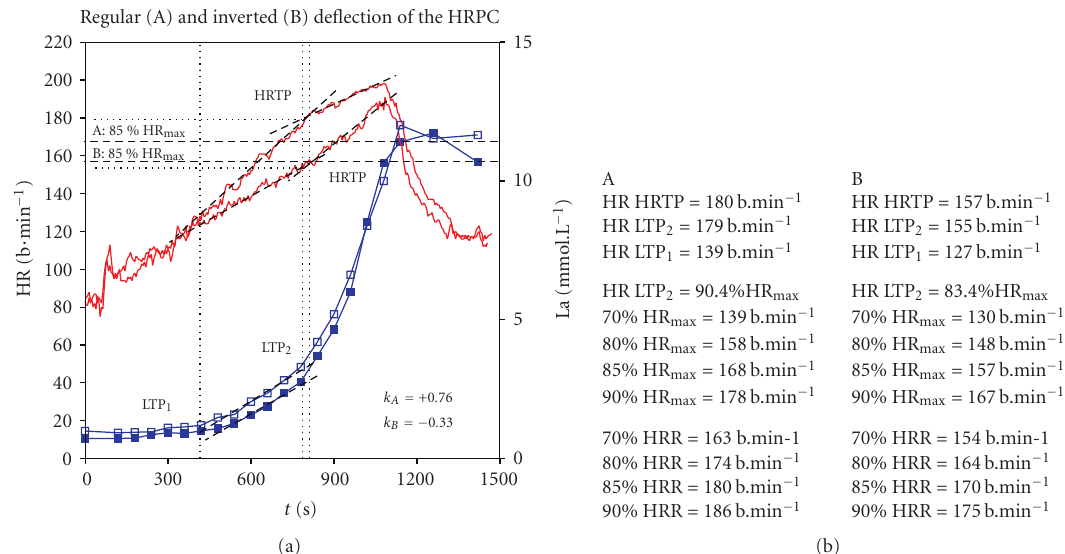
Figure 2: Accuracy of target training heart rate dependent on the time course of the Heart Rate Performance Curve. The same relative intensity of 85% HR max (usual upper limit) gives di ff erent work load related to the anaerobic threshold (LTP 2 ) [29]. Subject (A) 85% HR max is well below HR LTP 2 ; subject (B) 85% HR max is already above HR LTP 2